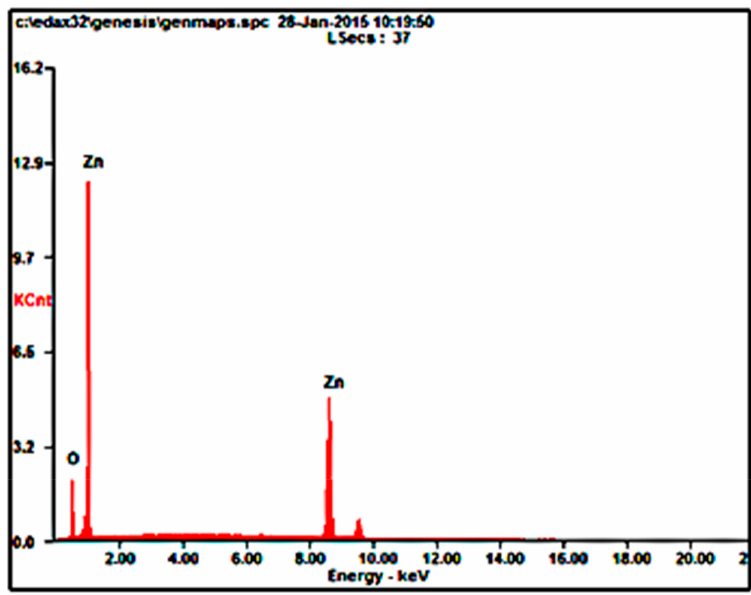
Figure 3. Energy dispersive spectroscopy (EDS) spectrum of